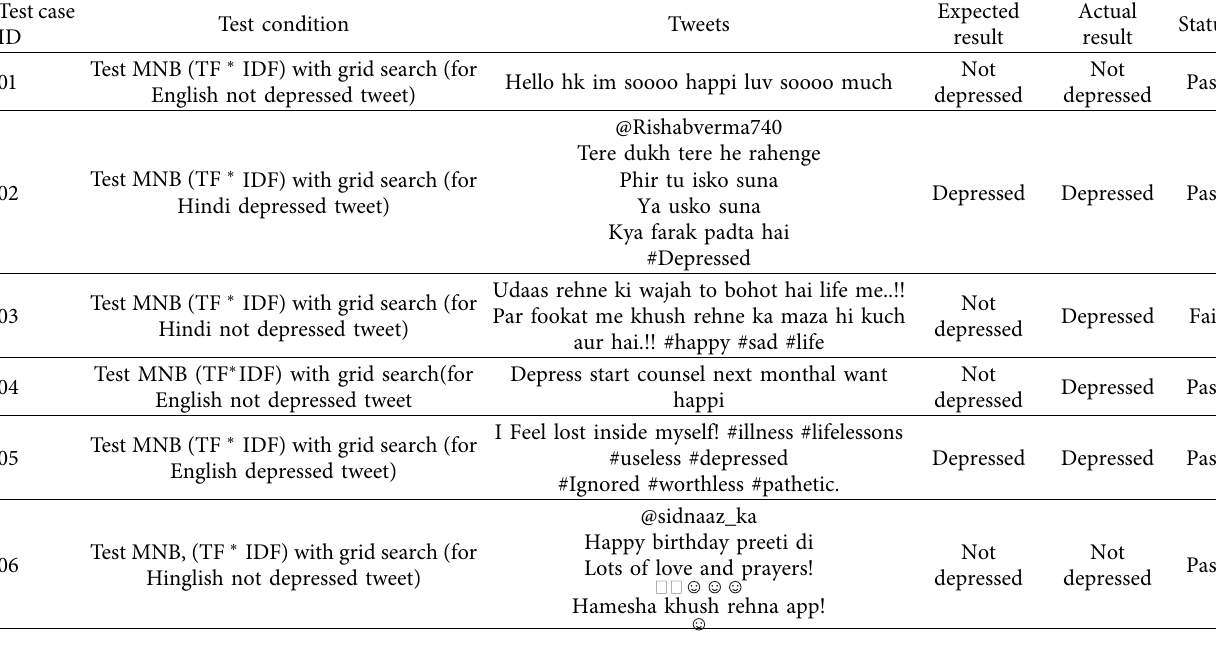
Table 2: Test cases for testing the model.